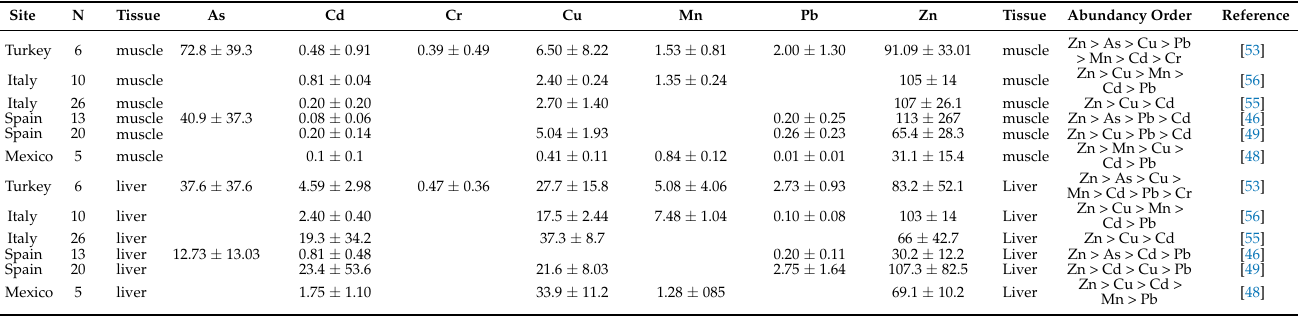
Table 1. Mean ± SD concentrations of heavy metals in sea turtle tissues and pattern of abundancy order over the last